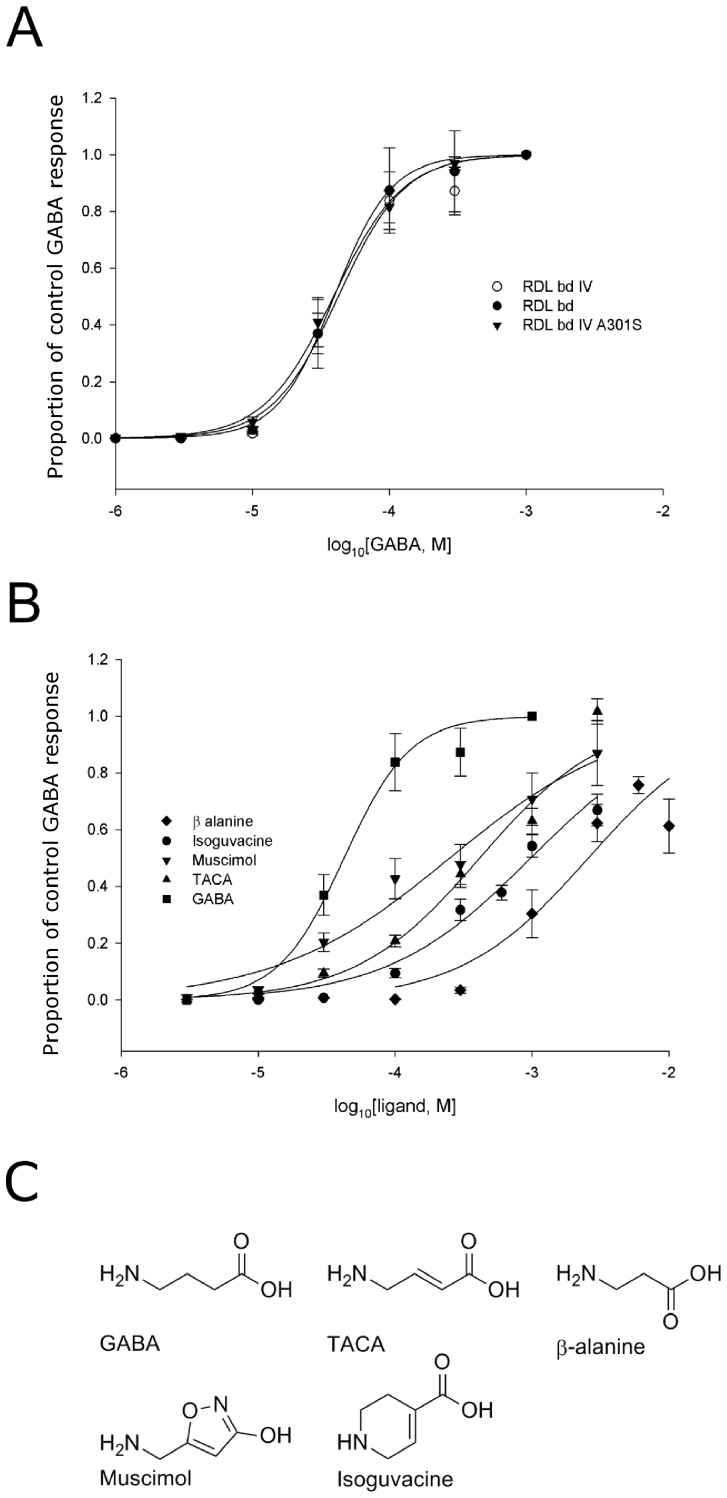
Concentration response curves for GABA and analogues mediated by variants of the RDLbd splice variant.(A) Concentration response curves for the three RDL subunits: RDLbd, RDLbdIV and RDLbdIVA301S to GABA (structure inserted). Data were normalised to 1 mM GABA. Each data point is the mean ± S.E.M from four to six oocytes from at least three separate frogs. Representative responses to 100 µM GABA are shown for each variant. Scale bars indicate 0.5 µA, 1 s. (B) Concentration response curves showing responses elicited by GABA and analogues at RDLbdIV receptors in Xenopus oocytes. GABA is the most potent agonist, and the rank order is GABA> muscimol> TACA>>β-alanine. Isoguvacine did not reach saturation. Data were normalised to the response to 1 mM GABA. Each data point represents mean±S.E.M from five to eight oocytes. (C) The chemical structures of the agonists tested in the present study: GABA (γ-amino butyric acid), TACA (trans-4-aminocrotonic acid), β-alanine, muscimol and isoguvacine.